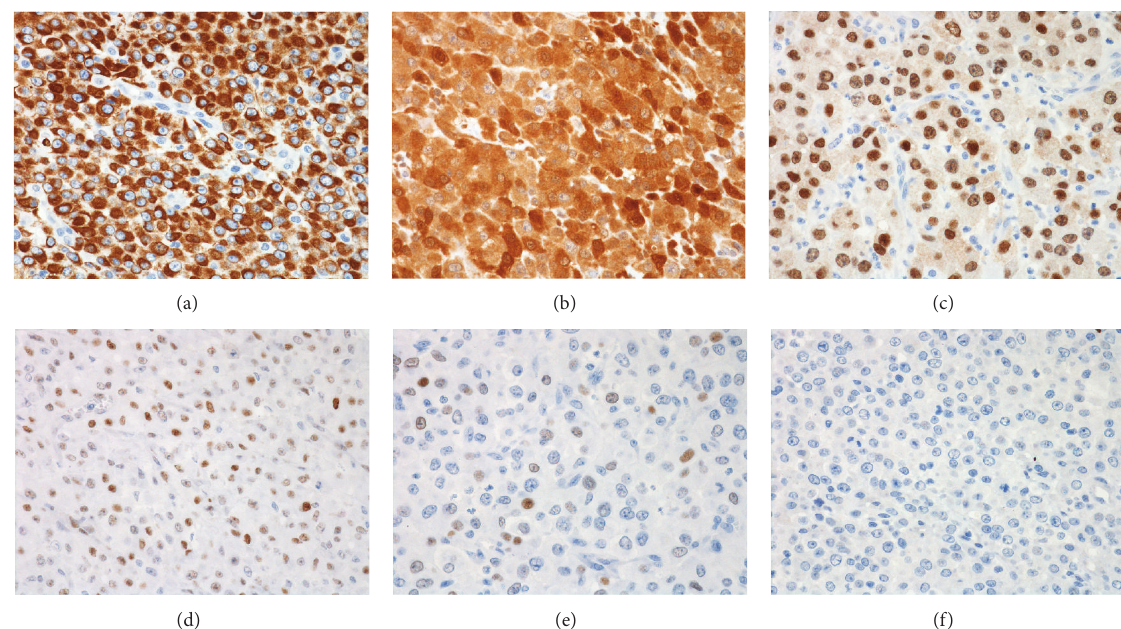
Figure 3: Immunohistochemical features of the tumor cells. The tumor cells showed diffuse positivity for AE1/AE3 (a), galectin-3 (b), and PAX-8 (c). There was patchy positivity for p53 (d). The tumor cells showed only weak focal positivity for TTF-1 (e) and were negative for thyroglobulin (f). All photographs at 400x